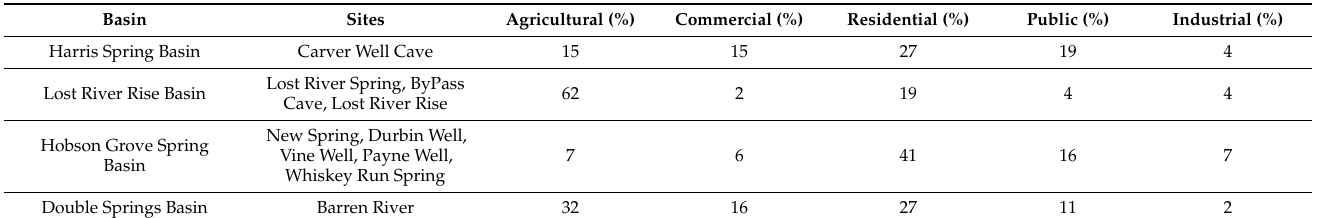
Table 2. Landuse percentage and sample site location within the defined groundwater basins for in Bowling Green,